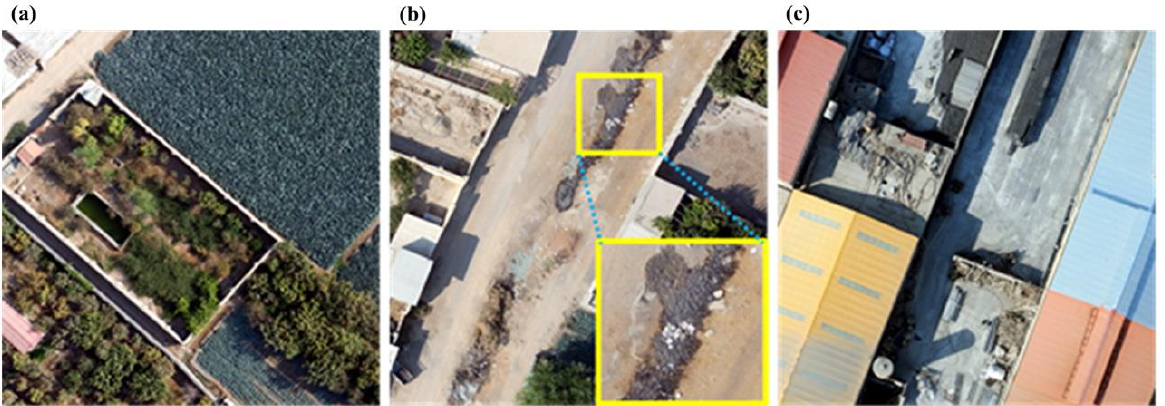
Figure 4. Various landscape types in the proposed dataset: (a) water and vegetation covers, (b) waste objects, and (c) different color